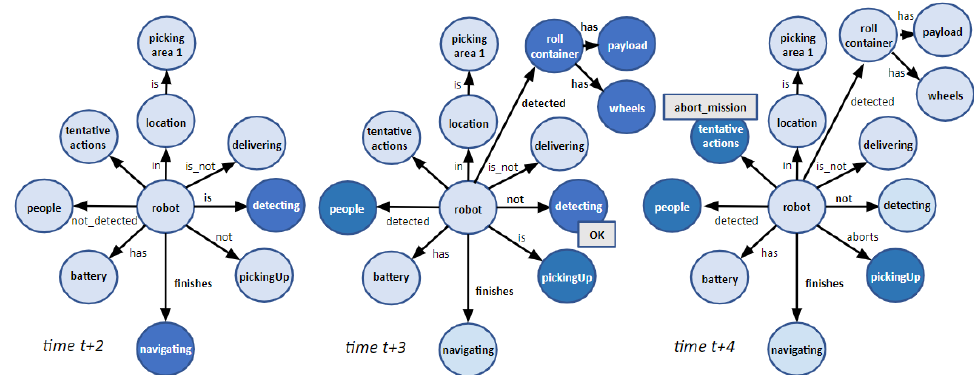
Figure 3. Modification of the nominal course of action: the detection of people close to the robot causes the robot to abort the pickingUp task (see text).